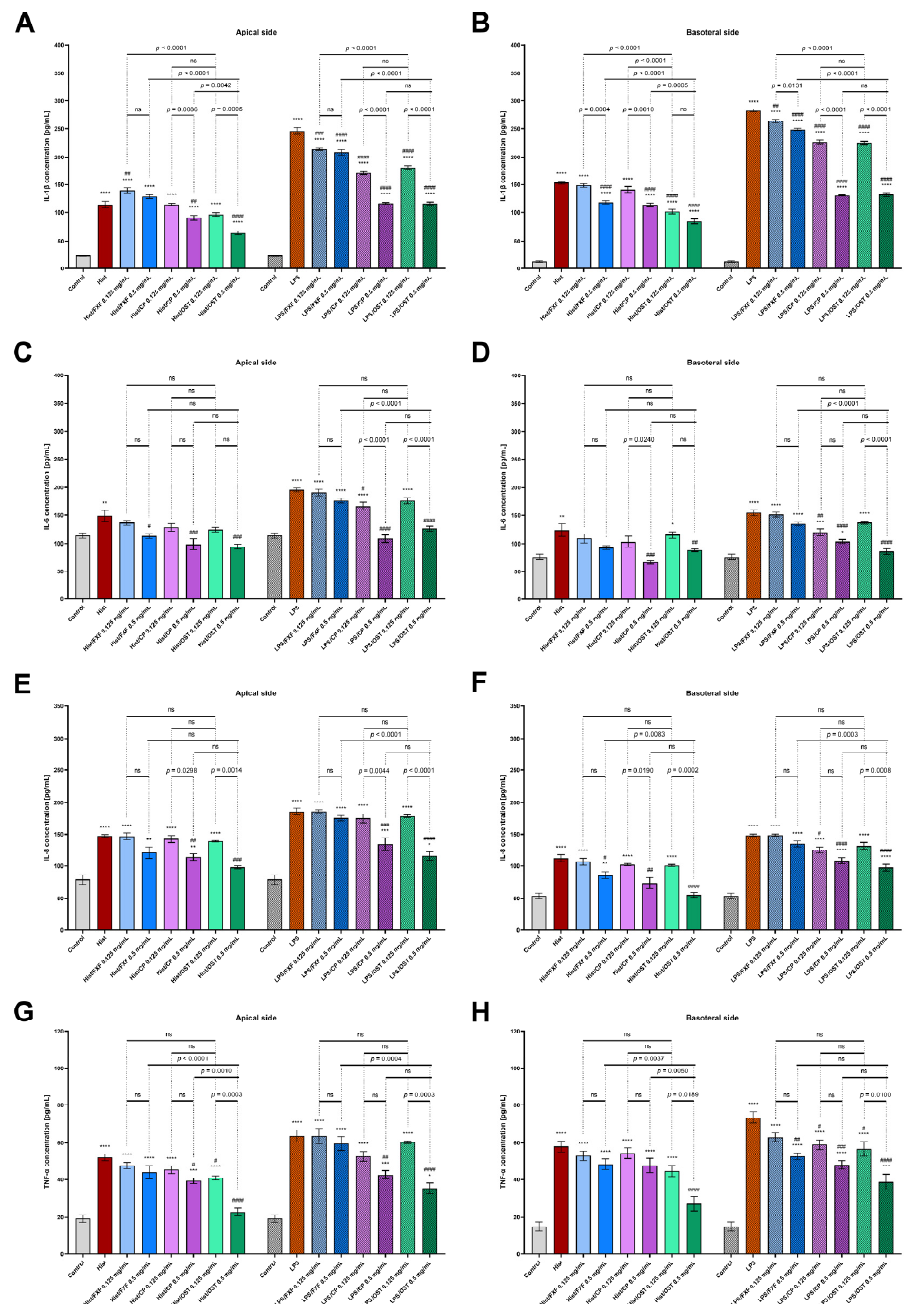
Figure 5. Secretion of IL-1 β ( A , B ), IL-6 ( C,D ), IL-8 ( E , F ) and TNF- α ( G , H ) in 3D skin model after incubation with histamine (Hist; 100 µ g/mL) and LPS (2 µ g/mL) alone and in the mixtures with fexofenadine (FXF), clobetasol propionate (CP) and osthole (OST; 0.125 and 0.5 mg/mL) on the apical ( A ) and basolateral sides ( B ). The horizontal line shows the mean and the bars show the standard error of the mean. Statistically significant differences (one-way ANOVA with Tukey’s multiple comparisons test) compared to control (*— p < 0.05, **— p < 0.01, ***— p < 0.001, ****— p < 0.0001) and to cells treated with histamine or LPS (#— p < 0.05, ##— p < 0.01, ###— p < 0.001, ####— p < 0.0001) are marked;